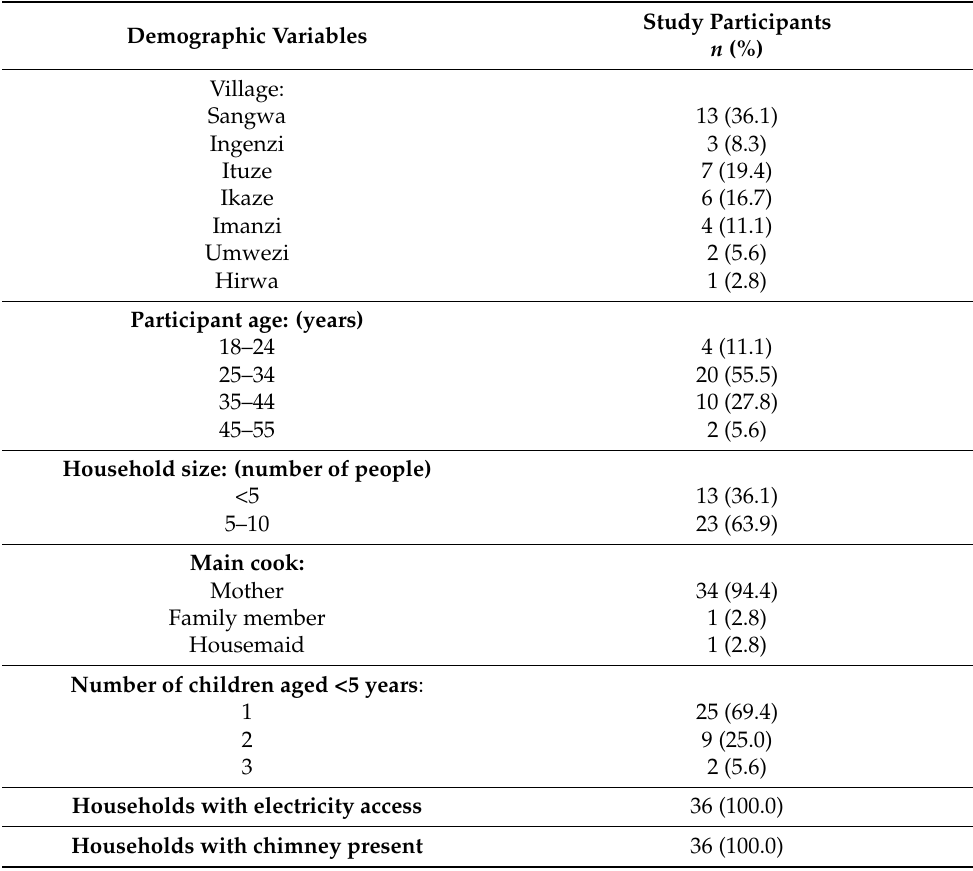
Table 1. Background demographic and household information ( n =